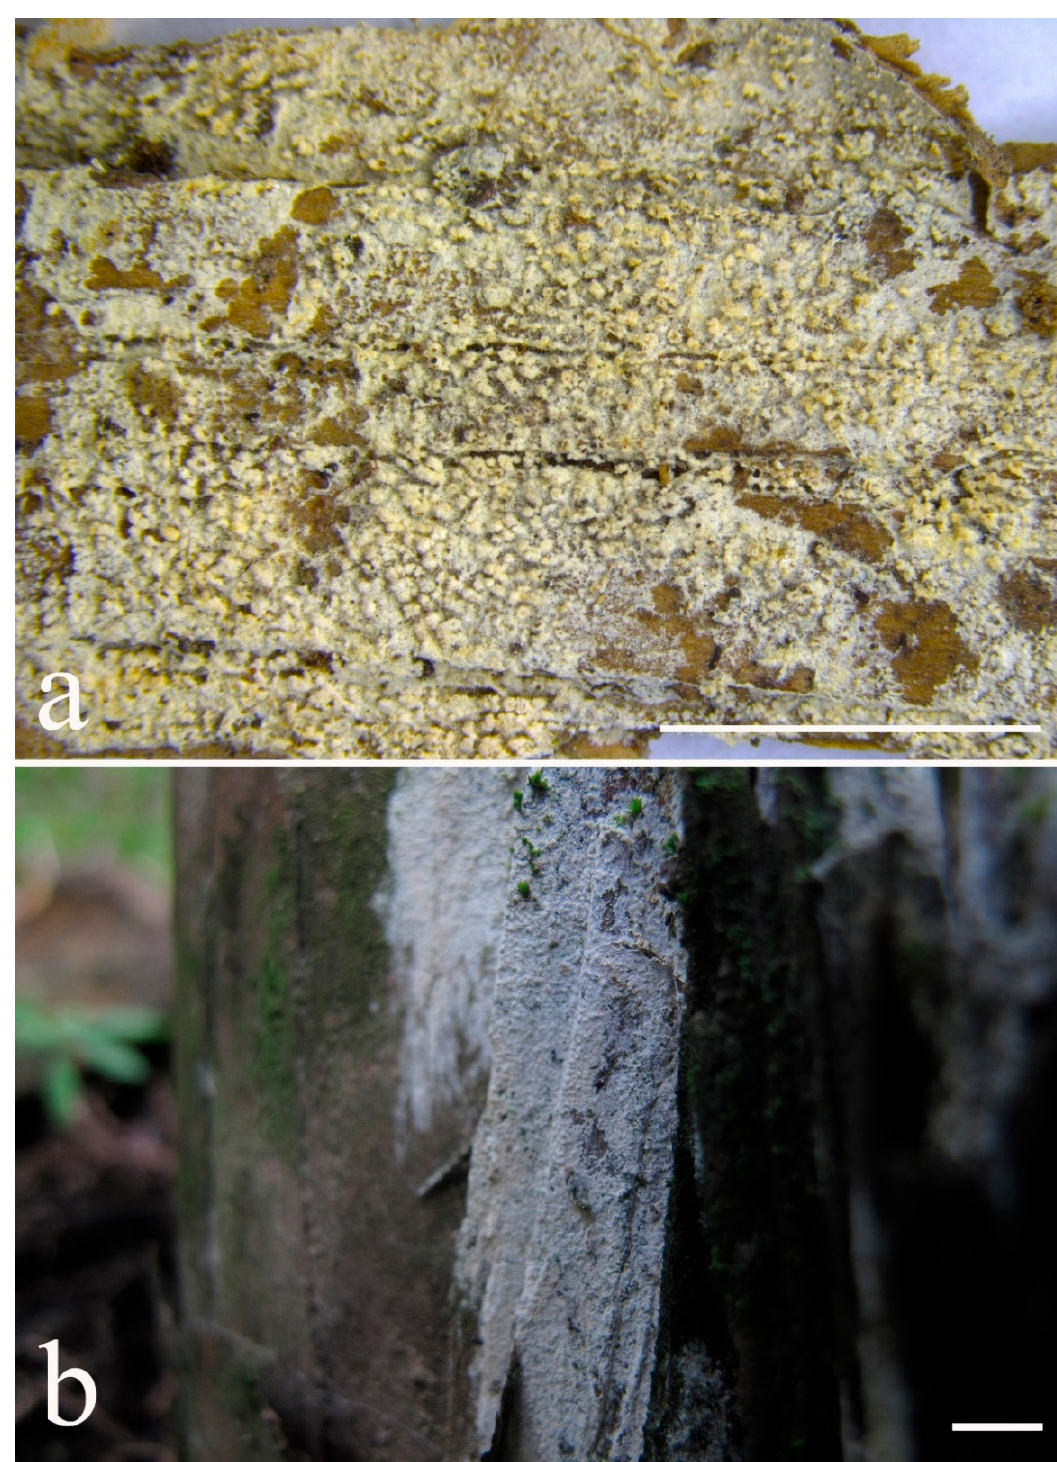
Figure 10. Basidiocarps of Hyphodontia pachyspora. ( a ) LWZ 20170908-5 (holotype); ( b ) LWZ 20180905-6 (paratype).—Scale bars: a = 5 mm; b = 1 cm.